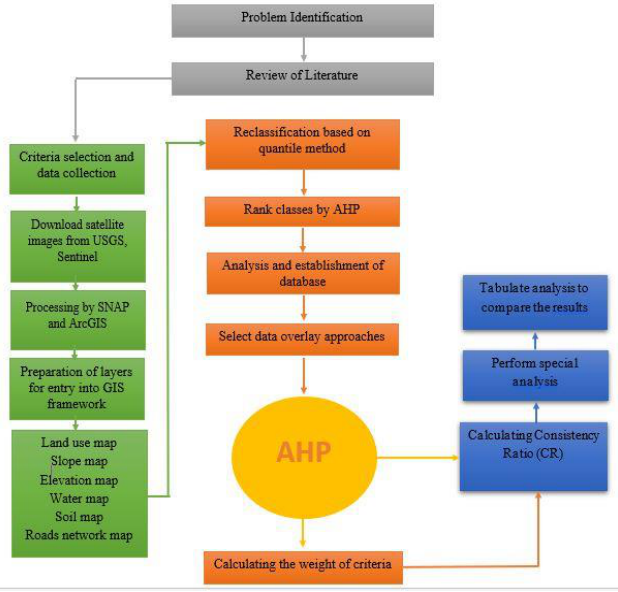
Figure 4 : Methodology used in this research.